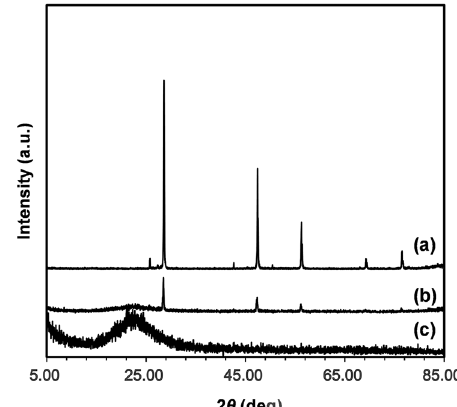
Fig. 6 XRD patterns of fresh silicon powder and recovered solid. a Fresh silicon powder, and ( b , c ) recovered solid samples after the catalytic reaction with TBAF ( b : 0.05 mmol, c : 1.0 mmol).